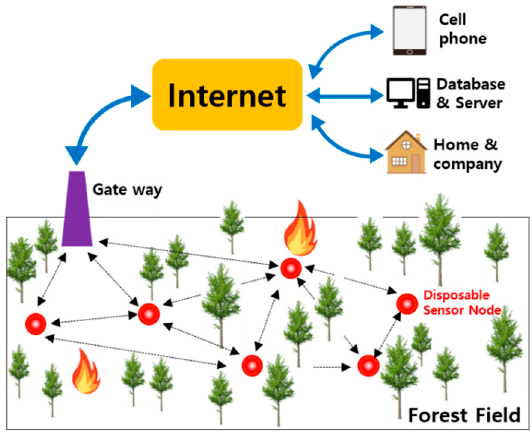
Figure 1. Diagram of Wireless Sensor Network (WSN).